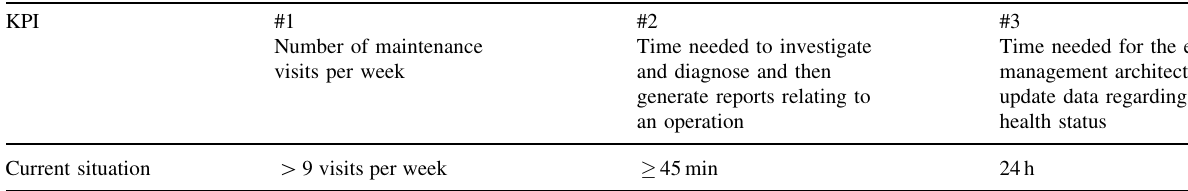
Table 1 Current situation for each KPI KPI